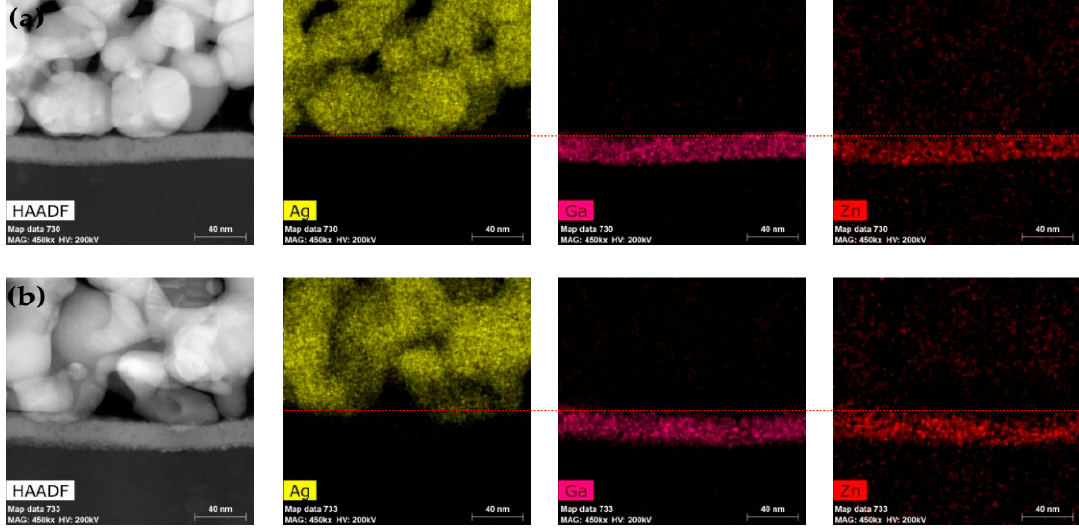
Figure 4. EDS mapping of Ag printed S/D electrodes TFTs with substrate temperature at ( a ) room temperature and ( b ) 60 °C .